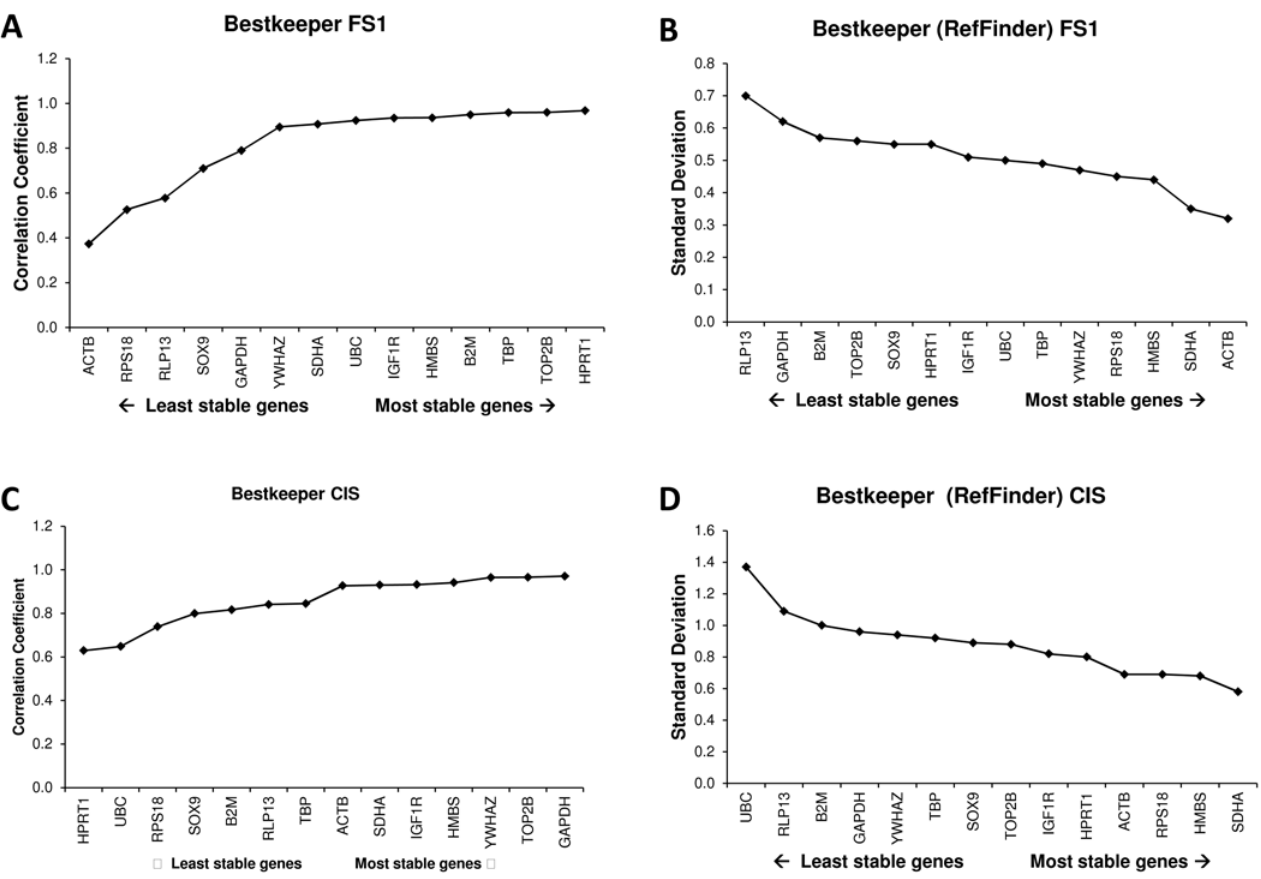
Fig 3. BestKeeper outputs of reference genes ranked by the correlation coefficients (A&C) or by their standard deviation (B&D) for the two datasets, i.e. FS1 (A&B) and CIS